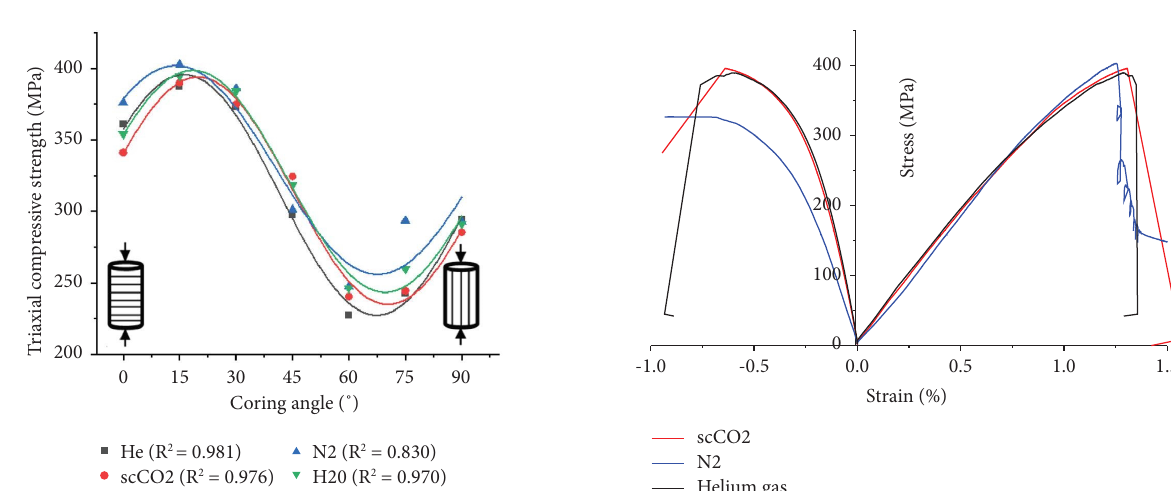
Figure 6: Stress-strain curves at the coring angle of 15 ° .